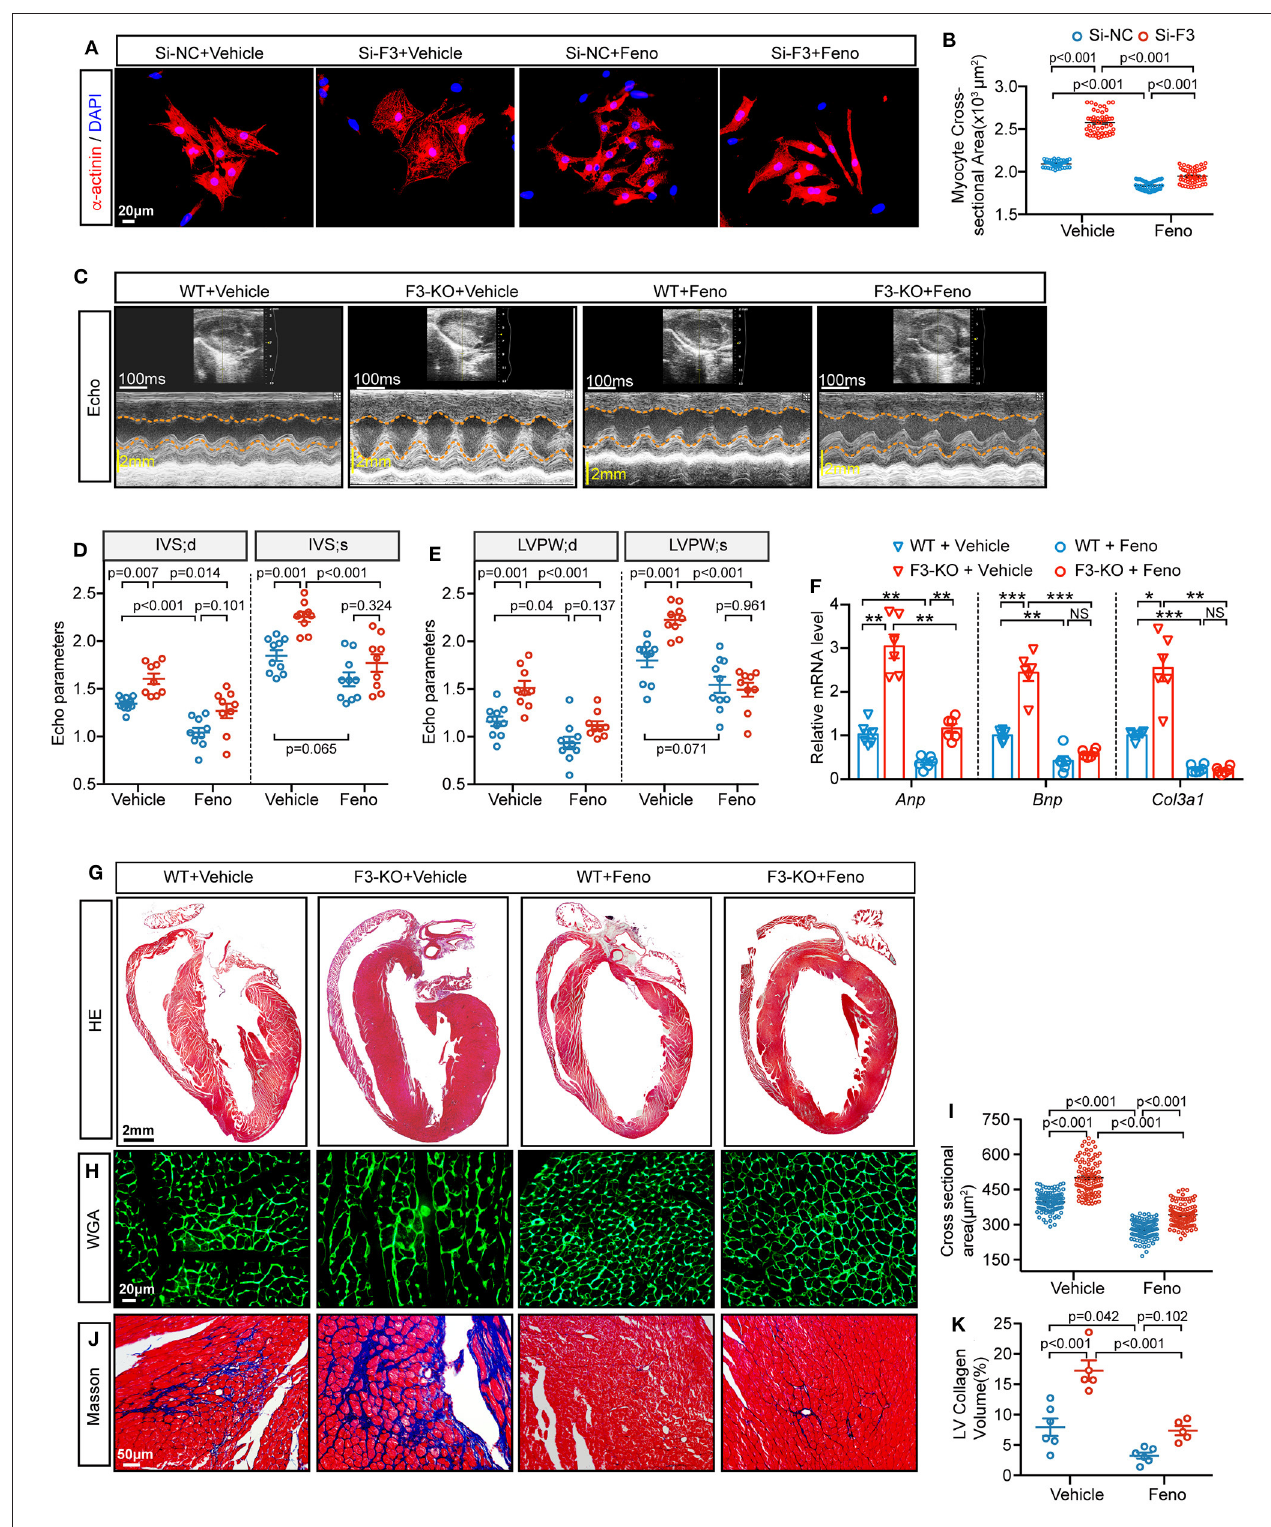
FIGURE 7 | Fenofibrate represses FABP3-null induced cardiac hypertrophy in vivo and in vitro . (A) NRVMs were treated with siRNA targeted Fabp3 (Si-F3) or its negative control before fenofibrate or vehicle treatment. Immunofluorescence staining of α -actinin used to compare the myocyte area. (B) Quantification of (A) . (C) Representative echo images in WT or F3-KO mice with or without fenofibrate treatment (Feno or Vehicle, respectively) at 4 weeks after TAC surgery. (D) Quantification